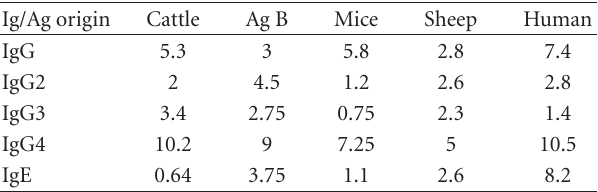
Table 11: The OD ratio of IgG calass, IgG subclass, and IgE of 30 human sample sera to crude HCF antigens of cattle, Ag B, mice, sheep, and